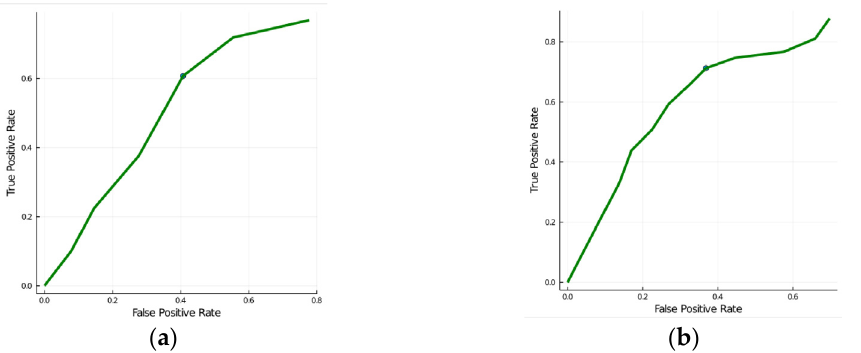
Figure 4. ROC curves for using texture features to distinguish between ( a ) PA versus EH and ( b ) PA + EH versus controls. C, controls; EH, essential hypertension; PA, primary aldosteronism .